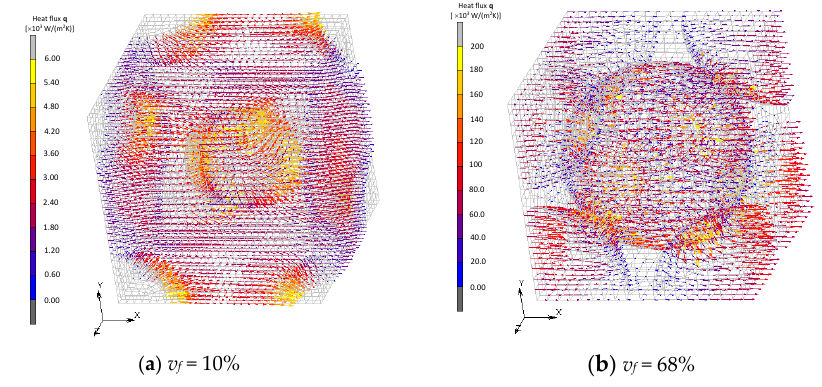
Figure 16. Heat flux field of BCC models.